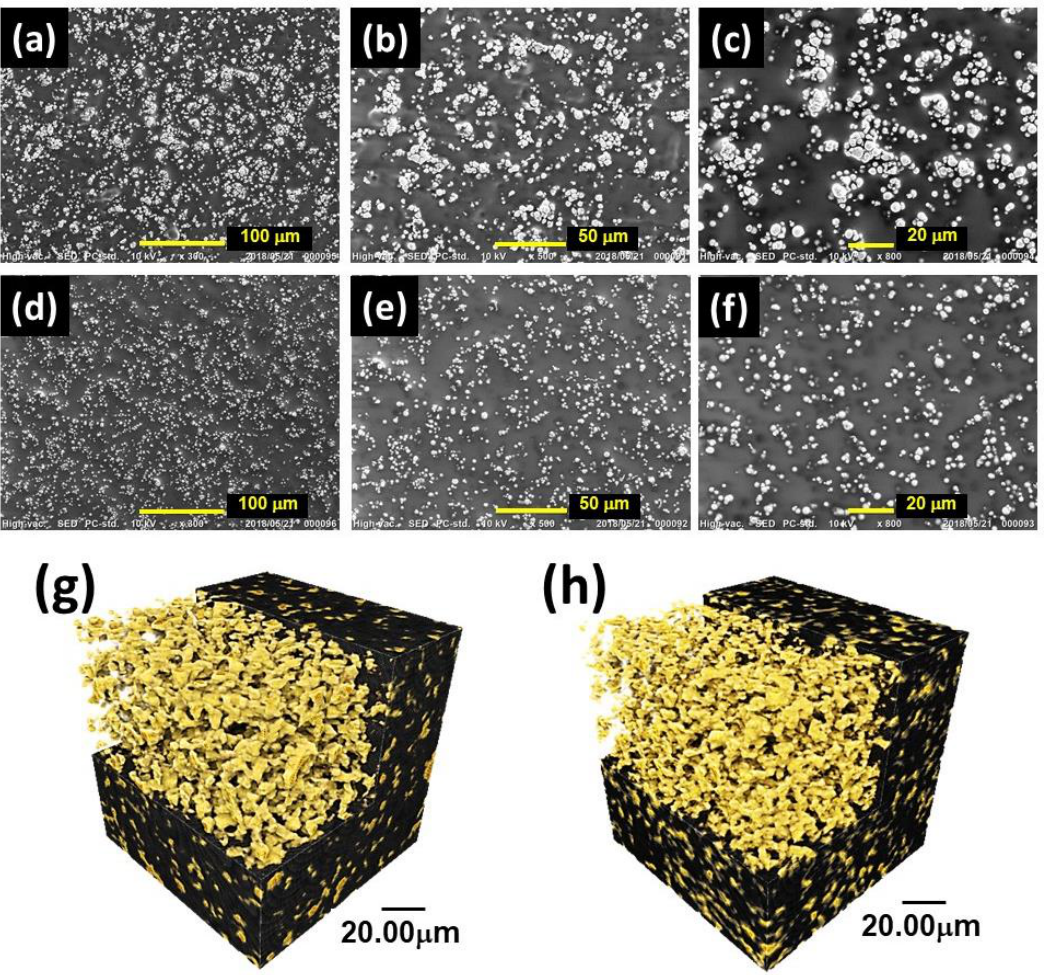
Figure 5. ( a – f ) SEM photographs and ( g , h ) computed tomography images for magnetic elastomers